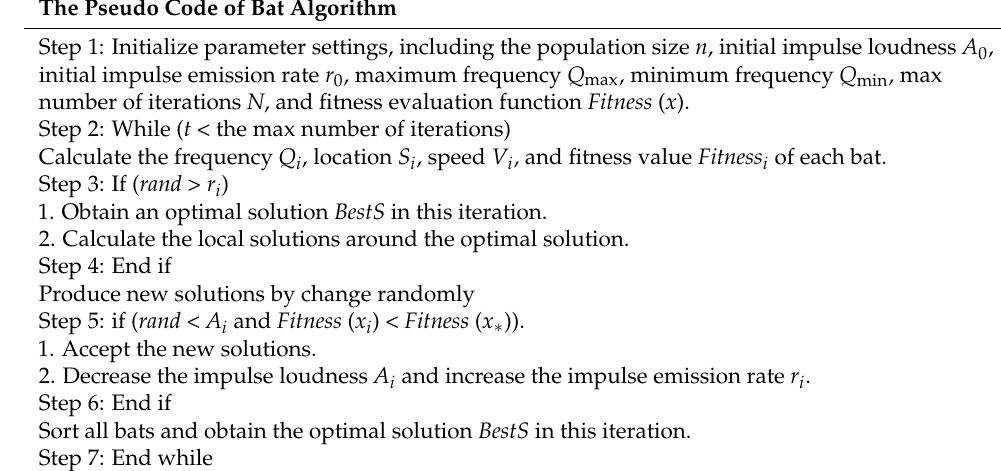
Table 2. Algorithmic process of BA. The Pseudo Code of Bat